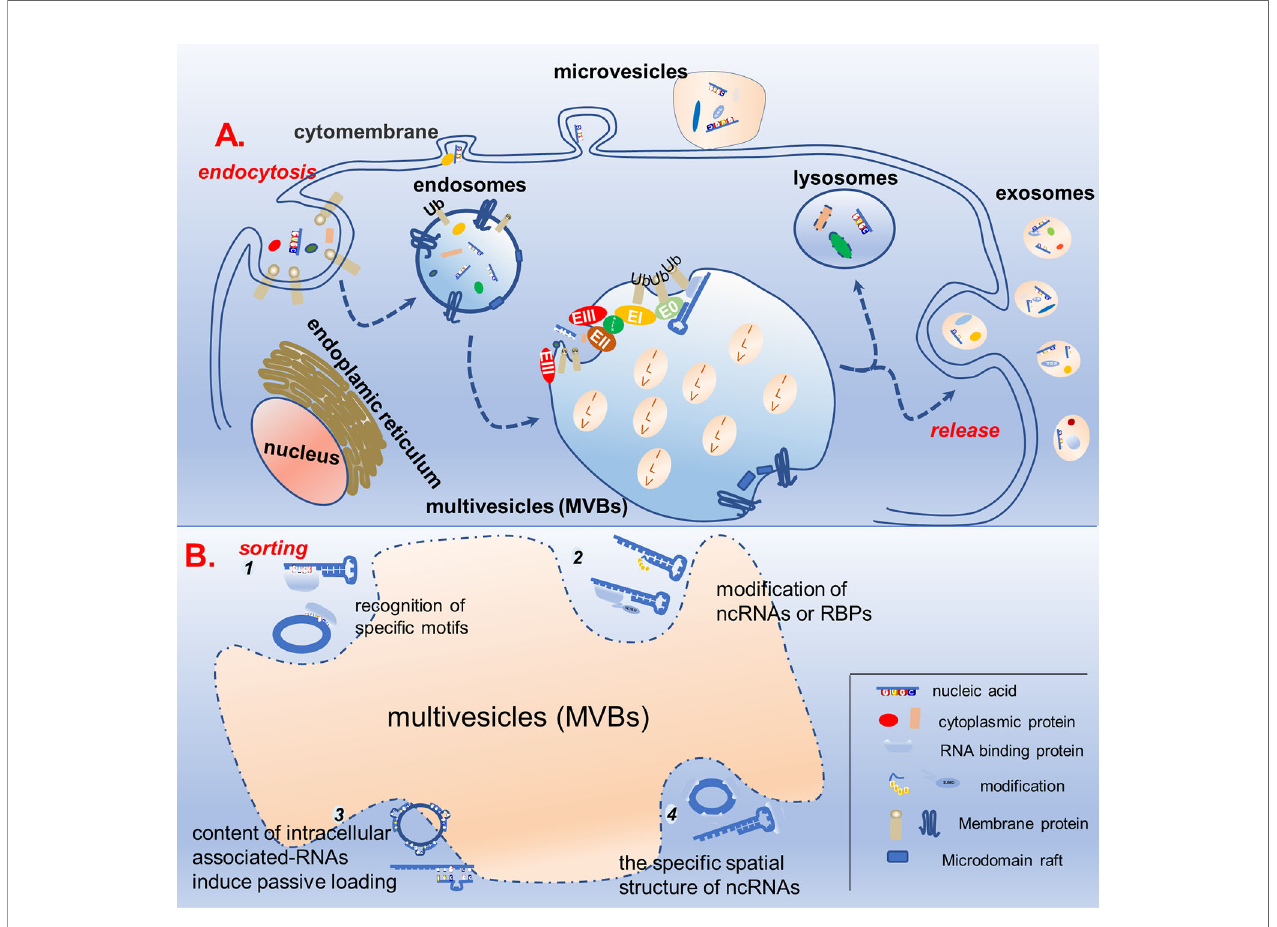
FIGURE 1 | Schematic diagram of exosome biogenesis and potential mechanisms for sorting non-coding RNA. (A) Proteins and nucleic acids are secreted into extracellular vesicles through budding and fi ssion of the cell membrane, while others enter the cell through the endocytosis pathway to form endosomes, which further mature into multivesicles bodies. In the multivesicles, membrane invagination, budding, and fi ssion results in the formation of ILVs in ESCRT-dependent and ESCRT-independent manners. ILVs either fuse with lysosomes to degrade the cargos or dock with the cell membrane to be released, forming biological exosomes. (B) In the process of ILVs formation, speci fi c non-coding RNAs are speci fi cally sorted into ILVs. There are four possible mechanisms, as follows: (1) recognition of speci fi c motifs on non-coding RNAs by RBP; (2) modi fi cation of non-coding RNAs or RBPs capable of binding to them to help them wrapped in ILVs; (3) the content of intracellular associated-RNAs modulate ncRNAs ’ sorting into ILV; (4) the speci fi c spatial structure of non-coding RNAs also affects its ability to enter